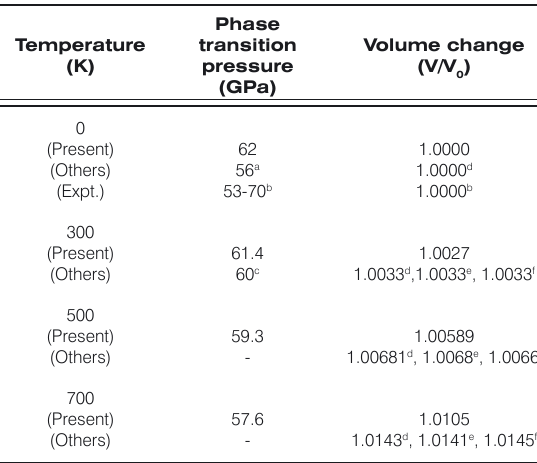
Table 2. Phase Transition pressure and volume change at different temperatures.